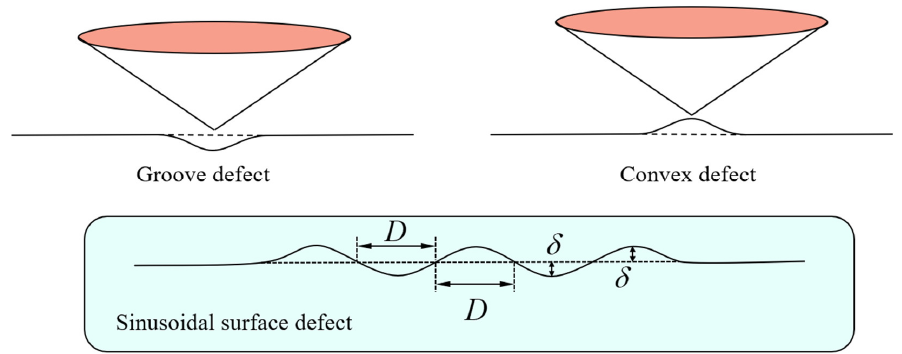
Figure 2. A sine curve is introduced to establish the defective surface, including groove defects and convex defects. D is the horizontal size of defects and δ is the height of defects. Contact positions of the indenter and the defective surface are groove position and convex position.